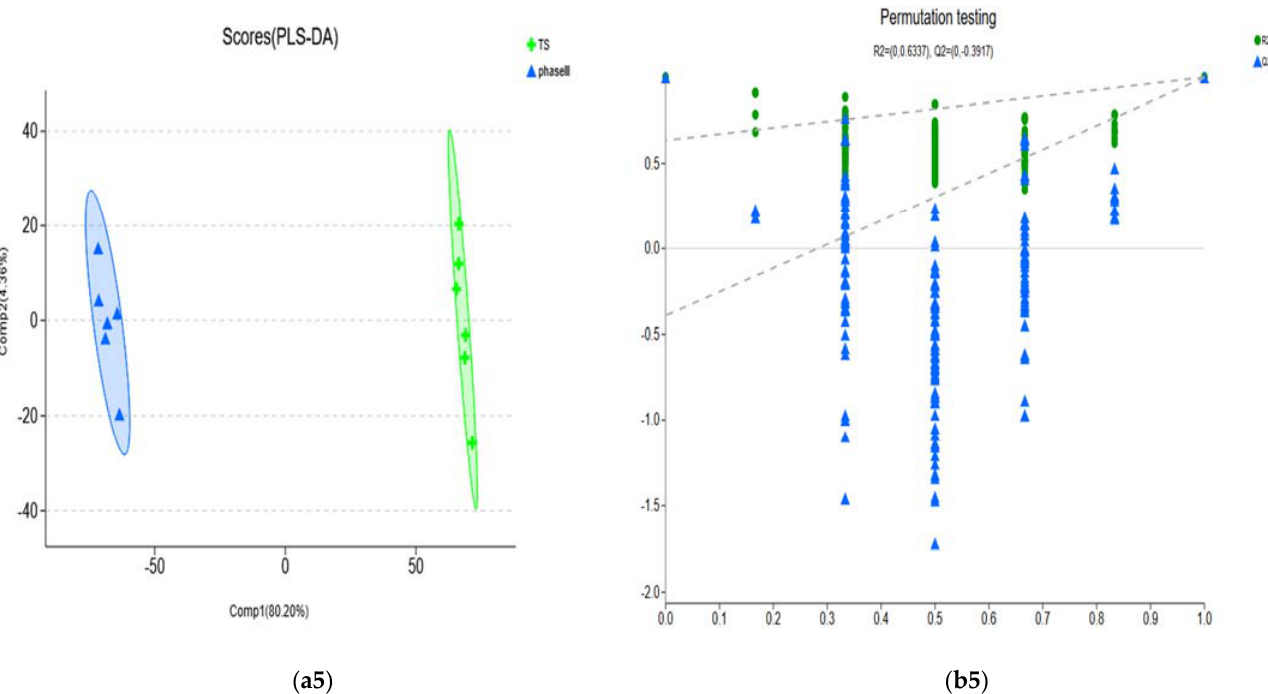
Figure 5. Score plots and permutation testing under the PLS-DA model for compost metabolites of different groups. ( a1 , b1 ) represent the PLS-DA analysis of N1F-TS comparison groups. ( a2 , b2 ) represent PLS-DA analysis of Phase I-Phase II comparison groups. ( a3 , b3 ) represent PLS-DA analysis of Phase II–Phase III comparison groups. ( a4 , b4 ) represent PLS-DA analysis of the TS-Phase II comparison groups. ( a5 , b5 ) represent PLS-DA analysis of the TS-Phase III comparison groups. PLS-DA model verification: The X-axis represents the permutation retention of the permutation test (Keep the scale consistent with the original model Y variable order. The point with the permutation retention of 1 is the R2 and Q2 values of the original model). The Y-axis represent the values of the permutation test for R2 (green dots) and Q2 (blue triangles). The two dashed lines represent the regression lines of R2 and Q2, respectively. Table 1. Parameters of differential metabolites based on PLS ‐ DA. Metabolic Set R 2 X (cum)